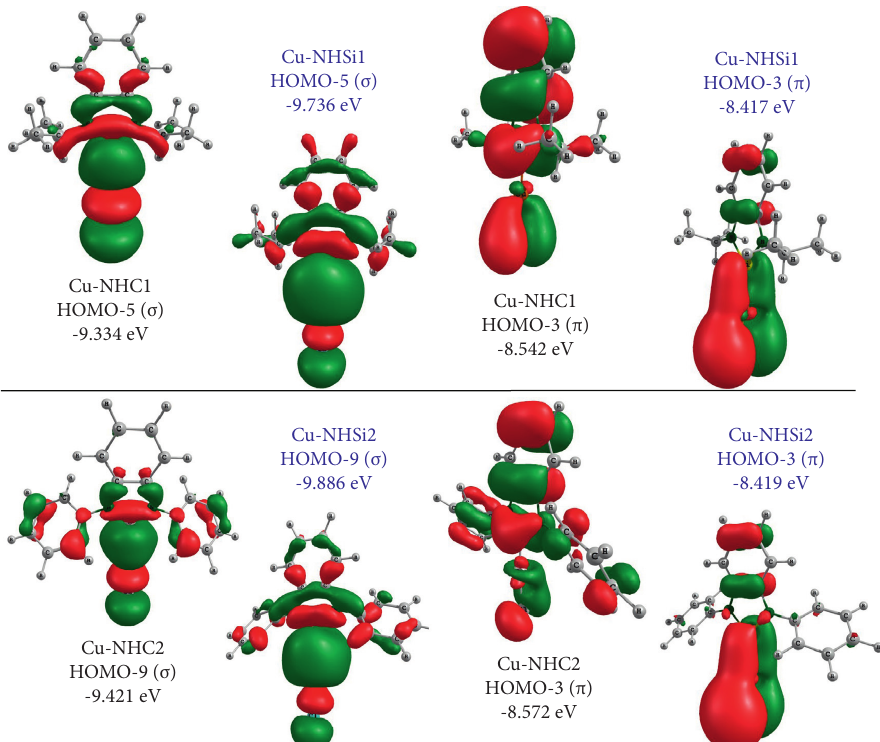
Figure 4: Molecular orbitals and orbital energy levels of σ - and π -types MOs of copper tetrylenes, Cu-NHC1, Cu-NHSi1, Cu-NHC2, Cu-NHSi2, at the level of theory BP86/TZVPP.